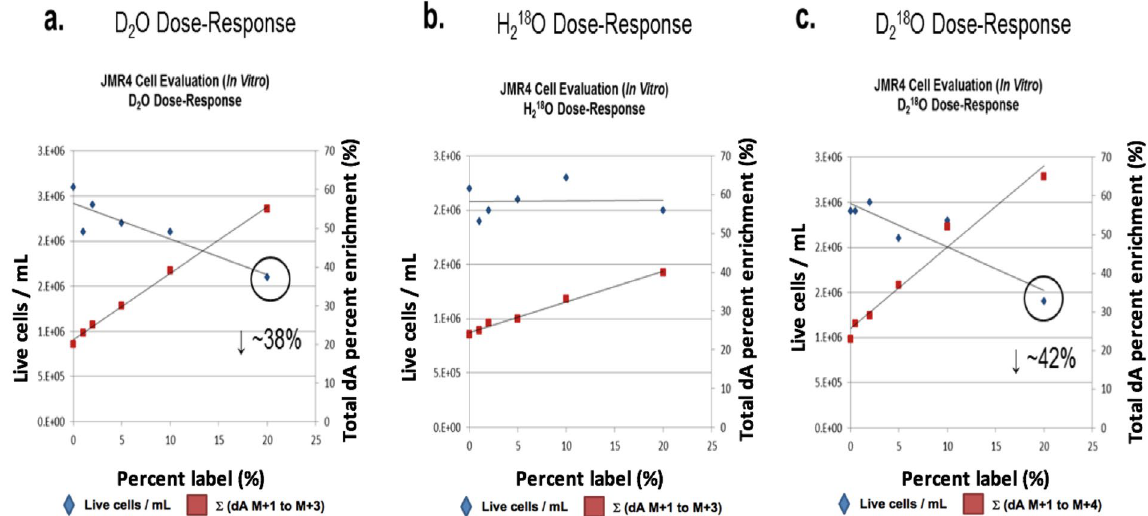
Figure 6. Heavy water dose-response effect on mouse thymus tumor cell viability (%) after 4-day incubation. ( a ) Total dA enrichments of mouse thymus tumor cells incubated in cell media fortified using 1 to 20% D 2 O (v/v) caused a reduction in proliferation and % cell viability at higher dosing levels (e.g. 20%, v/v). ( b) Total dA enrichments of tumor cells incubated in cell media fortified using 1 to 20% H 218 O (v/v) had no apparent effect on proliferation or % cell viability. ( c ) Total dA enrichments of tumor cells incubated in cell media fortified using 1 to 20% D 218 O (v/v) caused a reduction in proliferation and % cell viability at higher dosing levels (e.g. 20%,